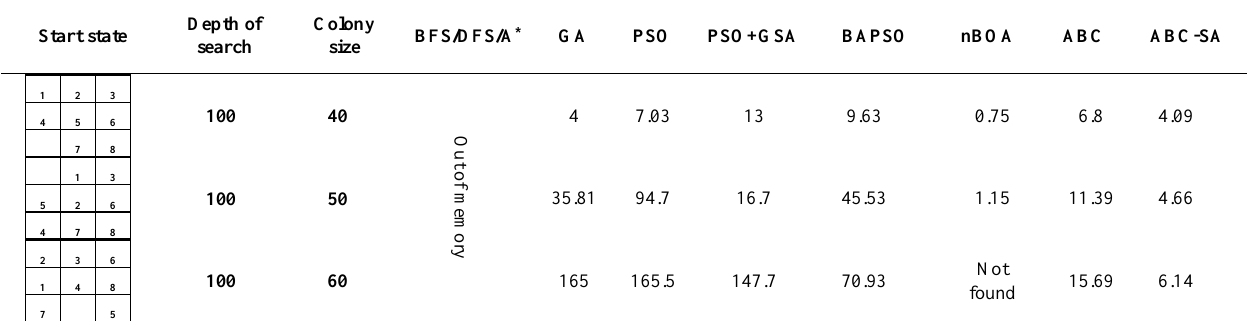
Table 5. Experimental results of different approaches to the 8-puzzle problem (average response time (s)). Start state